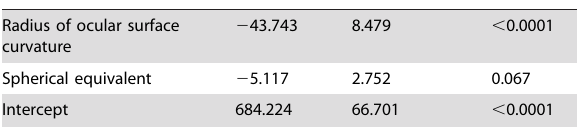
Table 6. Results of the multiple linear regression analysis with the stepwise method in which the maximal ocular surface displacement was the outcome